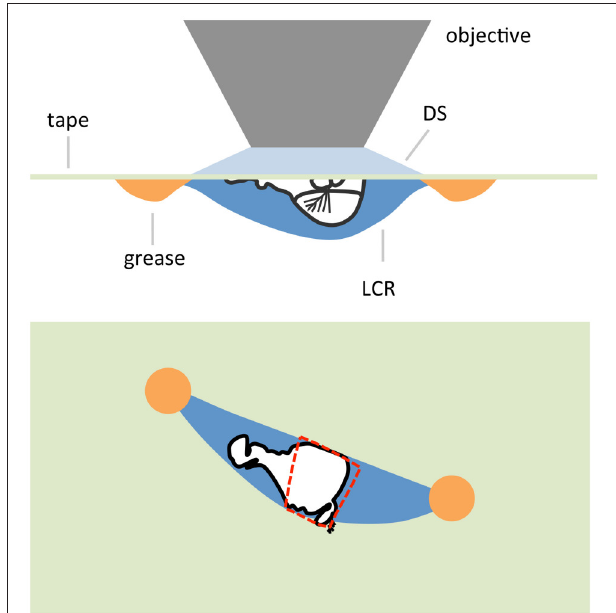
FIGURE 9 | Schematic of an air-gogga preparation. Upper panel, side view. Lower panel, top down view. The dashed red line represents a hole cut into the tape to allow saline to enter the